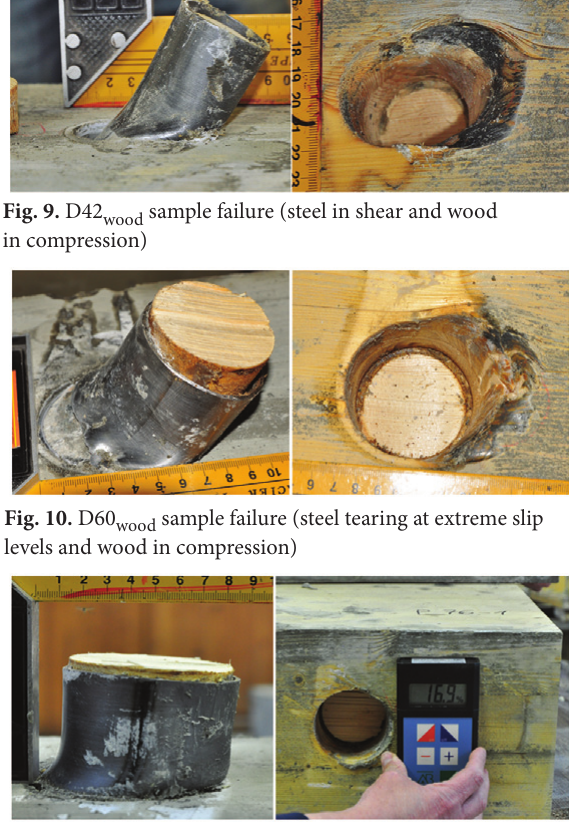
Fig. 11. D76 wood sample failure (steel section in shear, wood in compression)